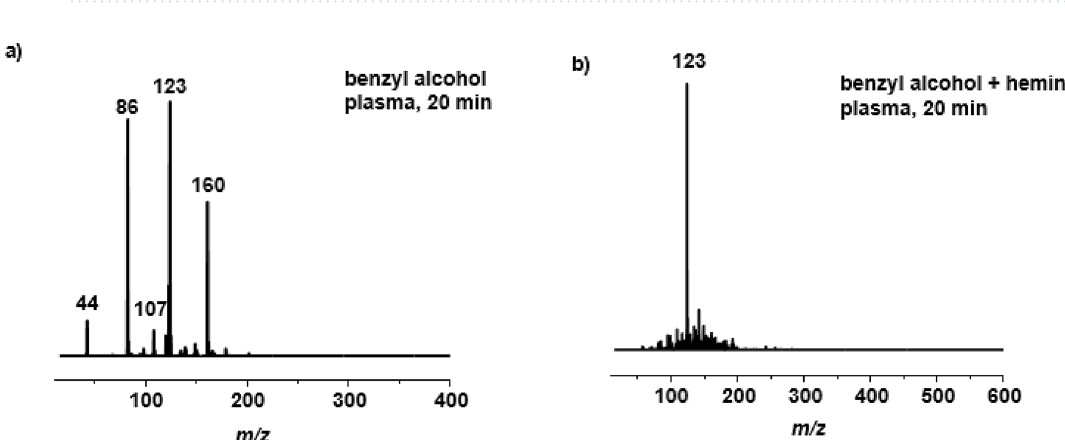
Figure 3. ESI-MS spectrum of benzyl alcohol after plasma treatment ( a ) without metal complex, ( b ) in the presence of complex B